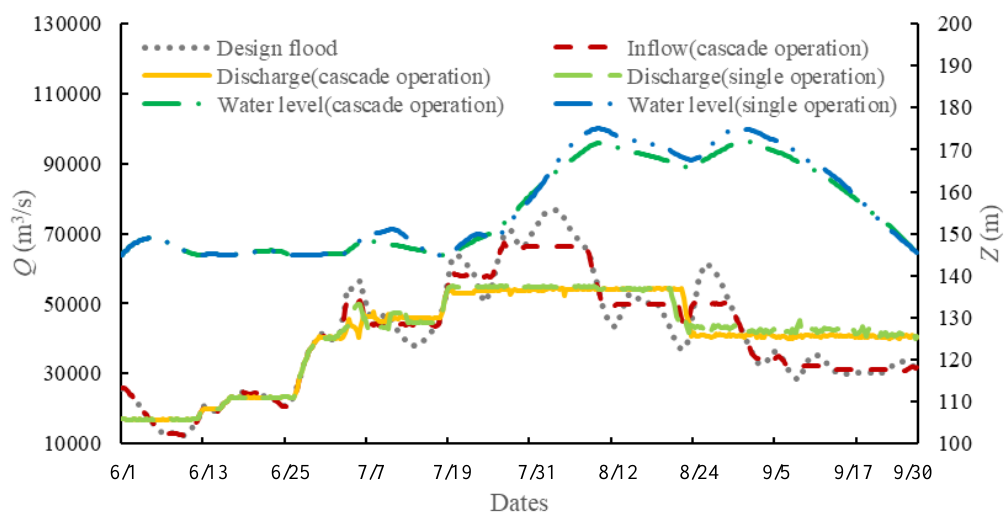
Figure 7. Discharge and water level hydrographs of TGR obtained by single and cascade optimal operation models for the 1954 DFH.